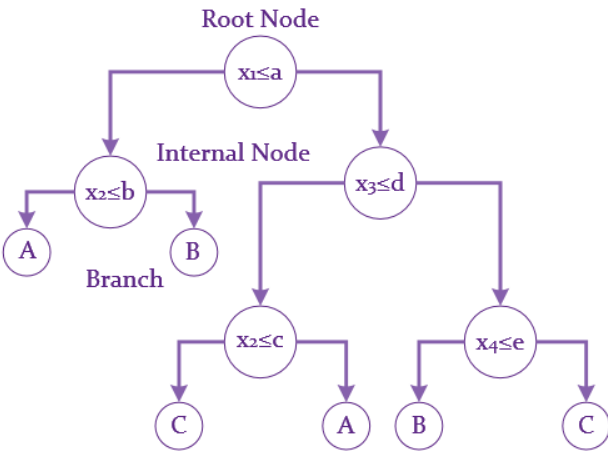
Figure 6. A decision tree structure consisting of three classes with four-dimensional property space.